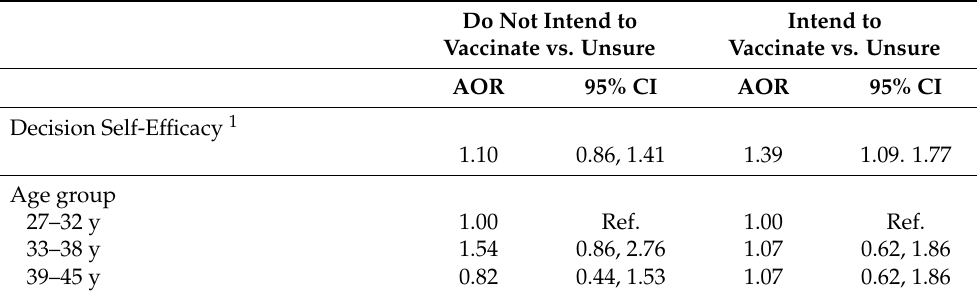
Table 2. Adjusted odds ratios and 95% confidence intervals for parental intention to